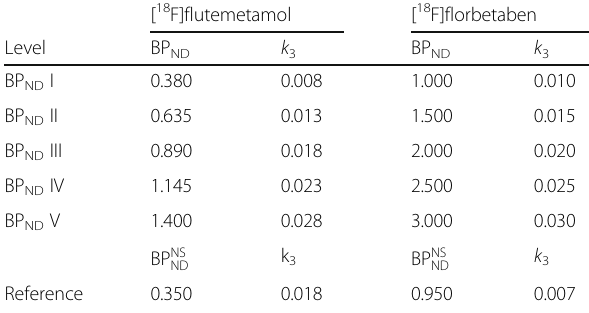
Table 1 Pharmacokinetic parameters for simulating TACs using 2T4k_V b